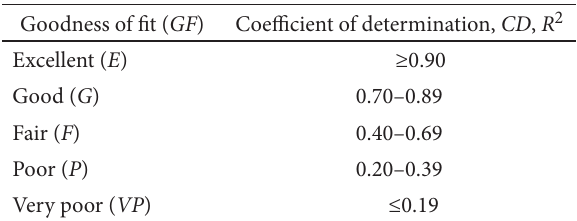
Table 8. Criteria for goodness of statistical relationship (Tran, Hall 2005)